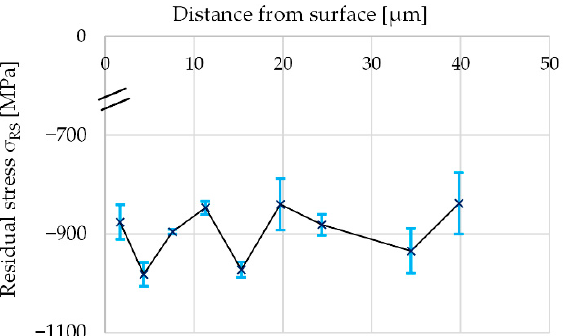
Figure 4. Residual stress profile with corresponding error indicators.